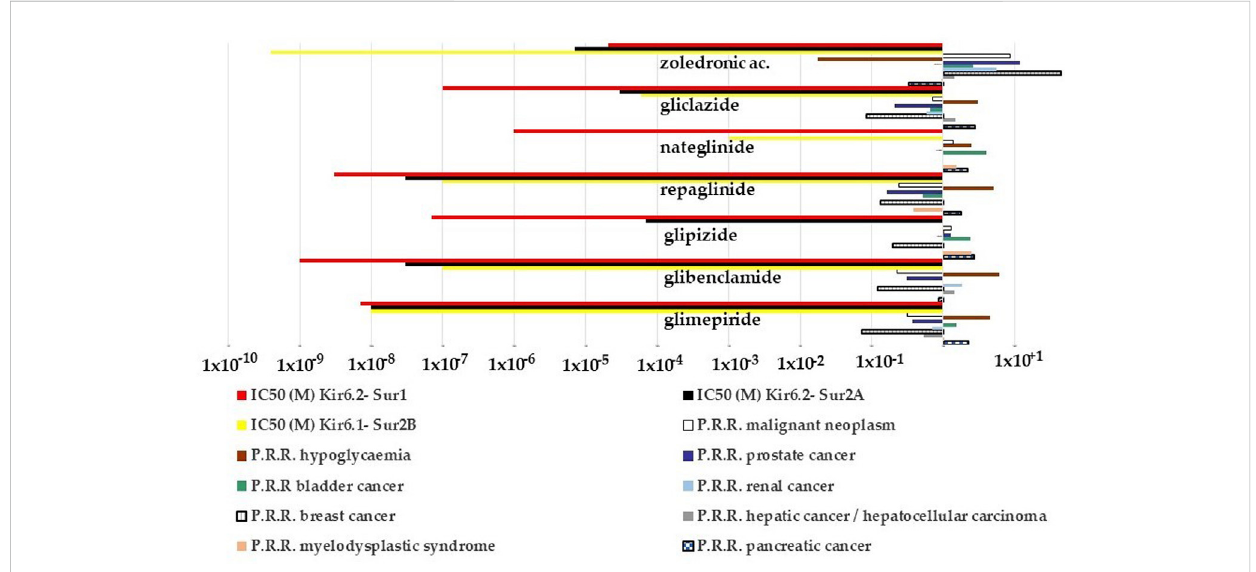
FIGURE 6 P.R.R. plot of different cancer types and hypoglycemia risks of the KATP channel blockers and their IC 50 values to block recombinant KATP channel subunits expressed in the cell line. The P.R.R. of hypoglycemia was > 2 for the sulfonylureas and glinides but not for zoledronic acid; the P.R.R. values for the pancreatic carcinoma were > 2 for the glipizide, glimepiride, nateglinide, and gliclazide; glipizide and nateglinide had a P.R.R. > 2 for bladder cancer, glipizide also for the myelodysplastic syndrome. P.R.R. values of breast and prostate cancers were < 1 for all sulfonylureas and glinides. P.P.R. values of zoledronic acid > 2 for all cancer types but lower values for pancreatic, renal, and bladder cancers. It also shows a low hypoglycemia risk. P.R.R. > 1 indicates a high risk of A.D.Rs., and lower values indicate a low risk of A.D.Rs. P.R.R. values > 2 are considered statistically signi fi